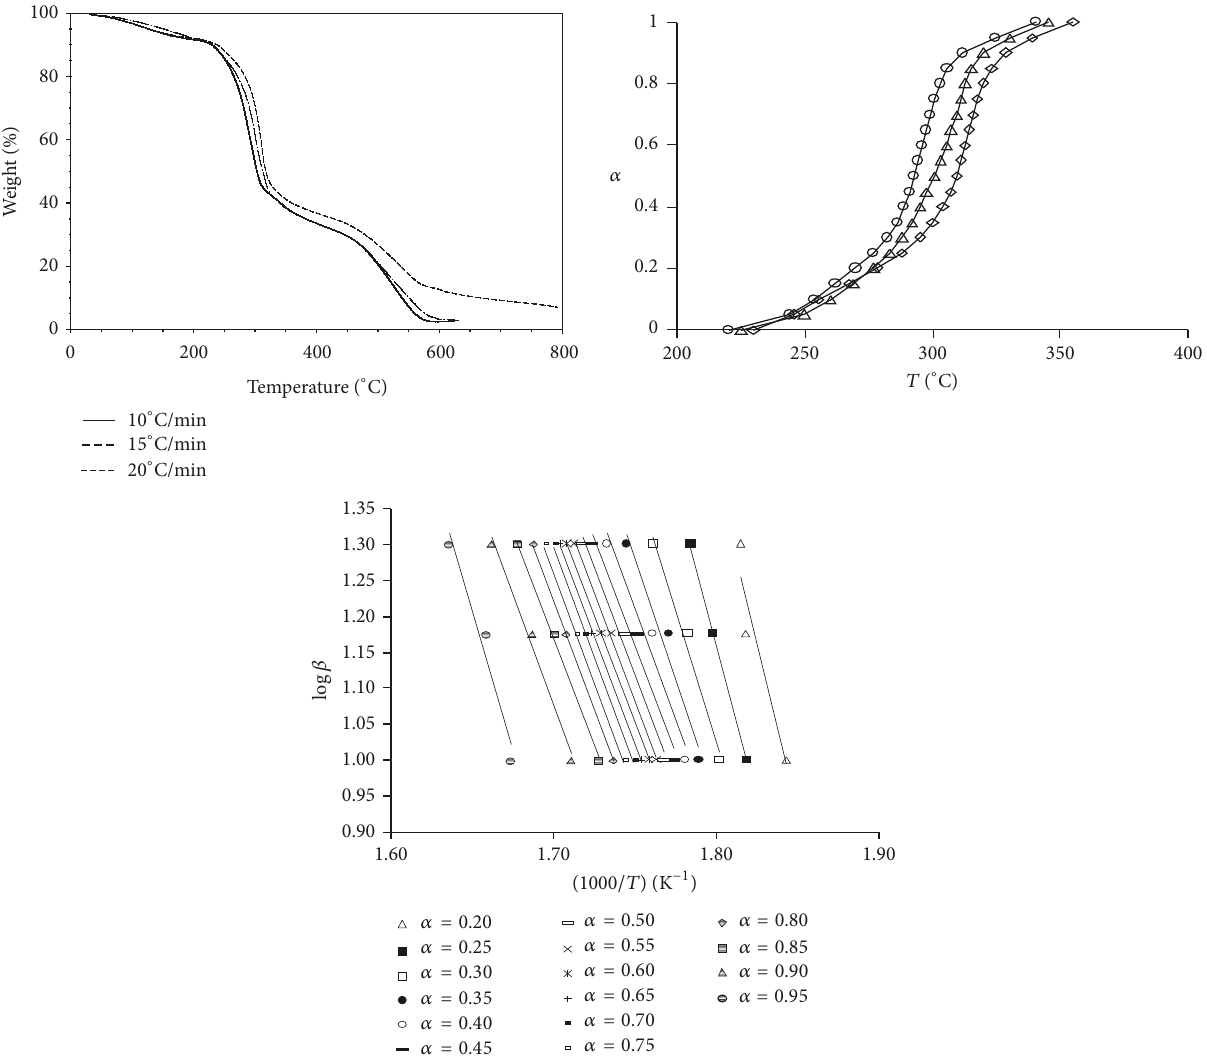
Figure 2: Thermogravimetric curves of ENa (L) and representative 𝛼 -T curve and logß (R) for ENa (R).